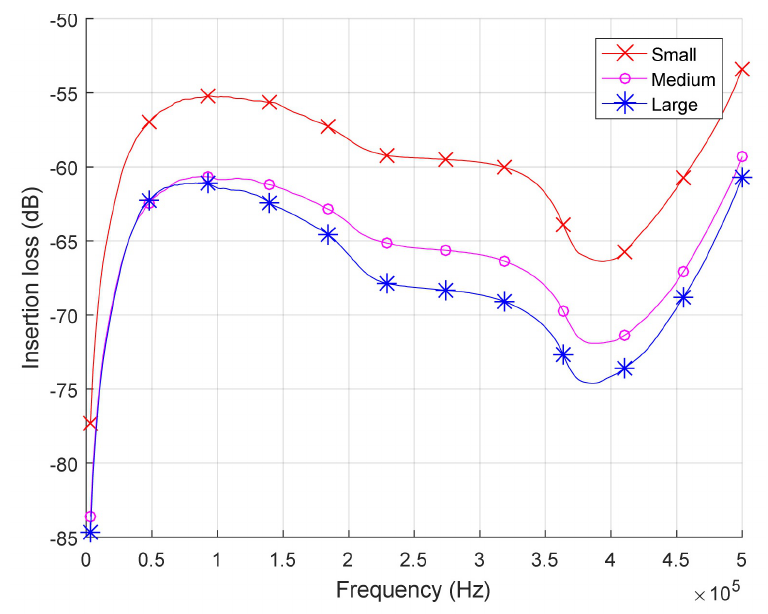
Figure 7. The average IL of the channels in the 1000 topologies for each house size.